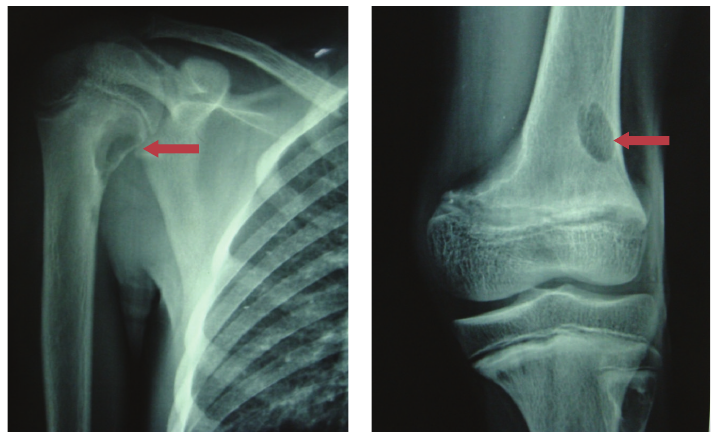
Figure 5: Osteoporotic changes in right humerus and left femur.